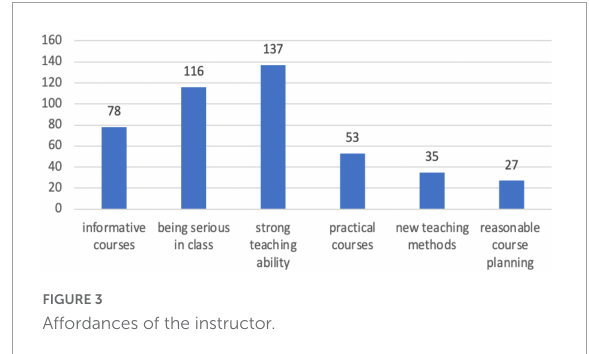
FIGURE3 Affordances of the